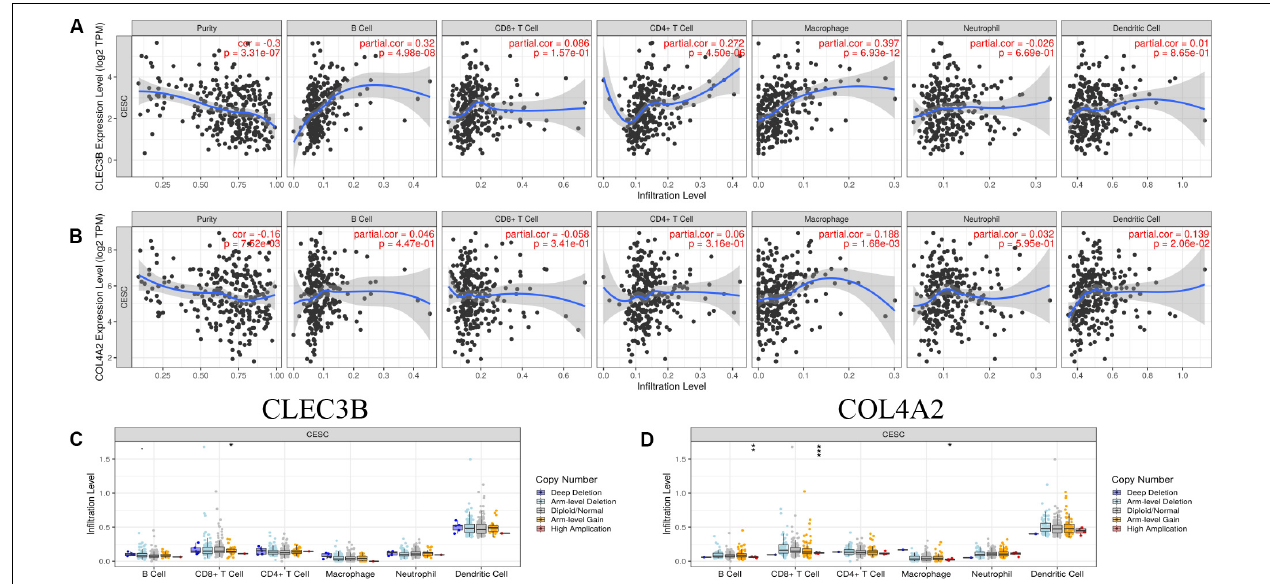
FIGURE 10 | Immune infiltrates analysis of hub TMB-related immune genes in CCC. (A,B) The correlation between the immune gene and the immune infiltration level. (C,D) Associations of the immune gene mutants with immune cells infiltration. TMB, tumor mutation burden; CCC, Cervical cell